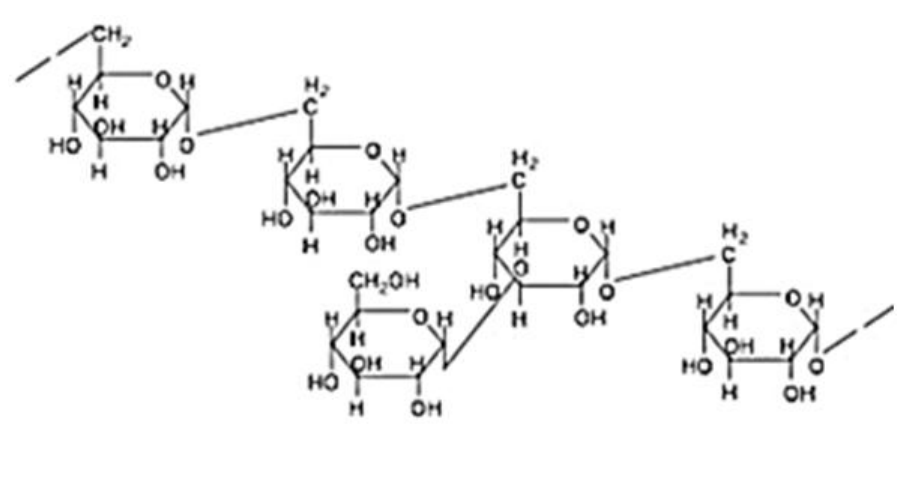
Figure 8. Fragment of